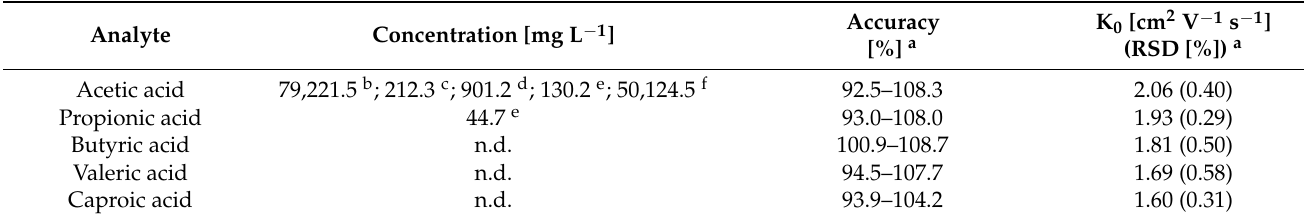
Table 2. Results of the analysis of real